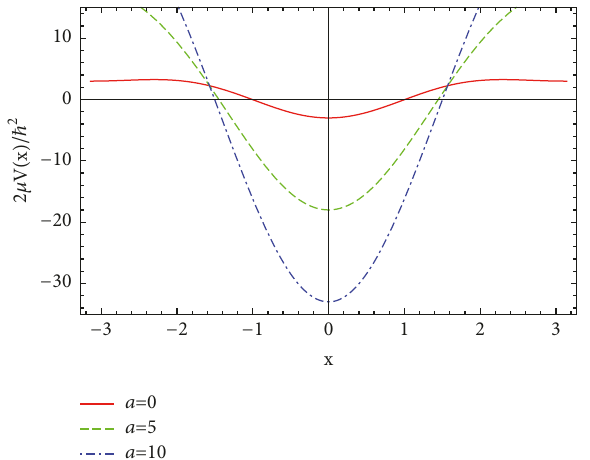
Figure 1: A plot of potential as function of the variables 𝑥 and 𝑎